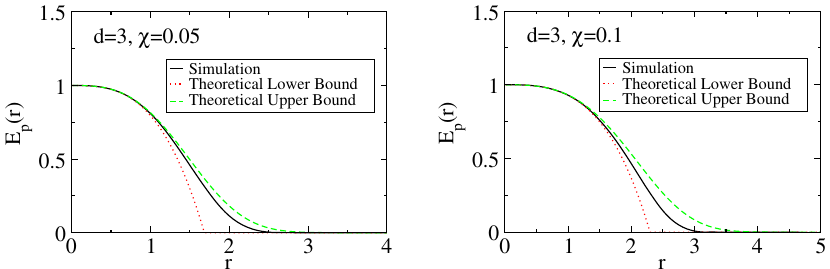
FIG. 10. Comparison of the lower and upper bounds (88) and (89) to our numerical results for the exclusion probability function E for χ ¼ 0 . 05 and χ ¼ 0 . 1 for d ¼ 2 . Here, K ¼ 1 .